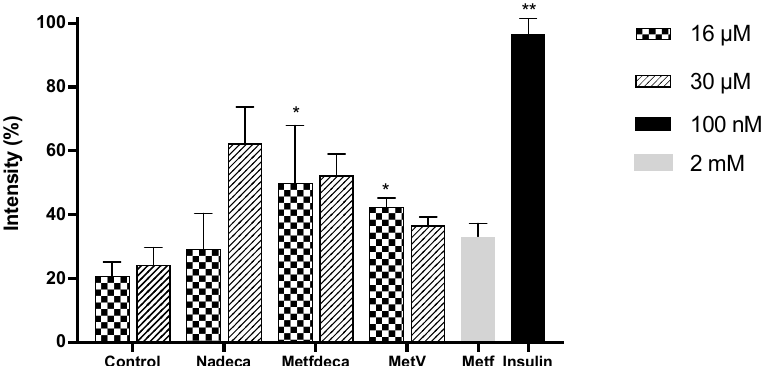
Figure 6. Effect of vanadium compounds on the glucose uptake in 3T3-L1 differentiated adipocytes at 16, 30 μM for vanadium compounds and 2 mM for Metf in the absence of insulin. All the values are the mean ± SD. * p < 0.05 and ** p < 0.01 vs. untreated control cells.